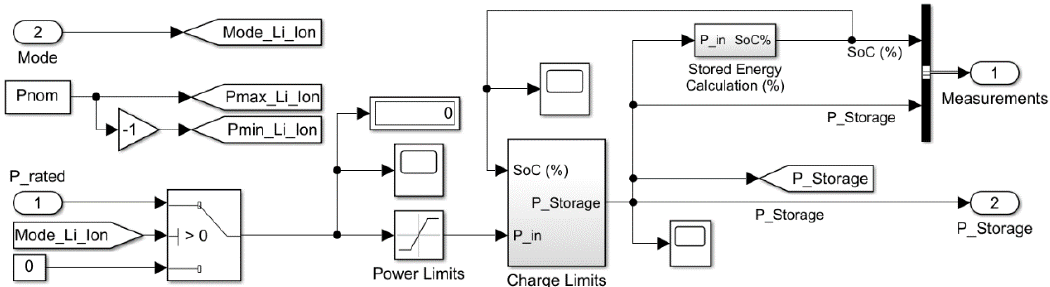
Figure 9. Simulink model of the lithium-ion battery (own figure based on